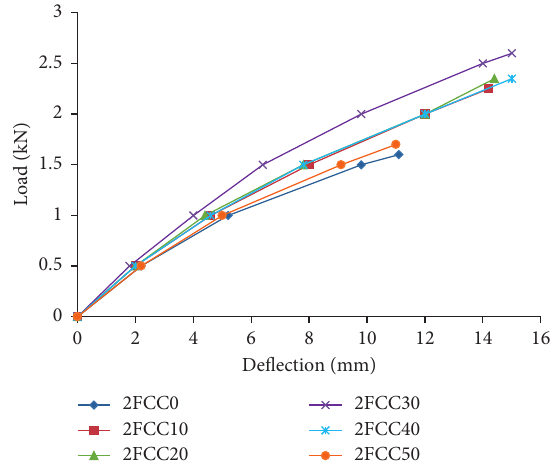
Figure 6: Load vs. deflection for ferrocement laminates with volume fraction 1.88%.